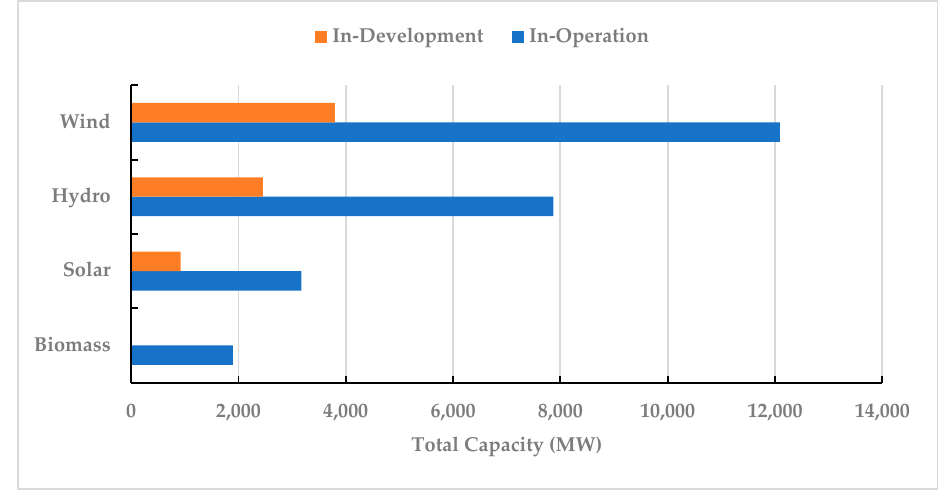
Figure 5. Total capacity electricity generation from renewable energy sources within remote and indigenous communities [31,33,88].